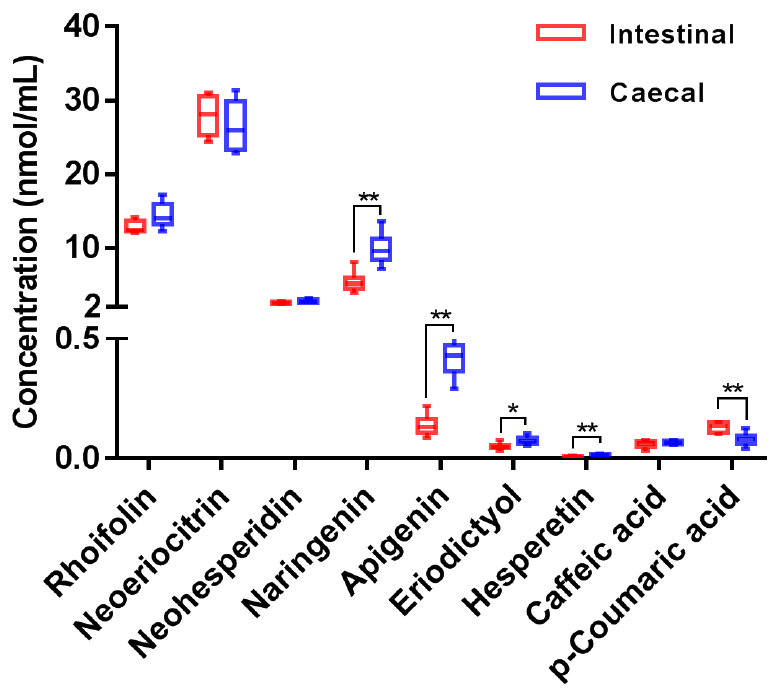
Figure 2. Measured concentrations of target analytes in rat fecal fermentation samples (compared with intestinal contents group; * p < 0.05, ** p < 0.01).